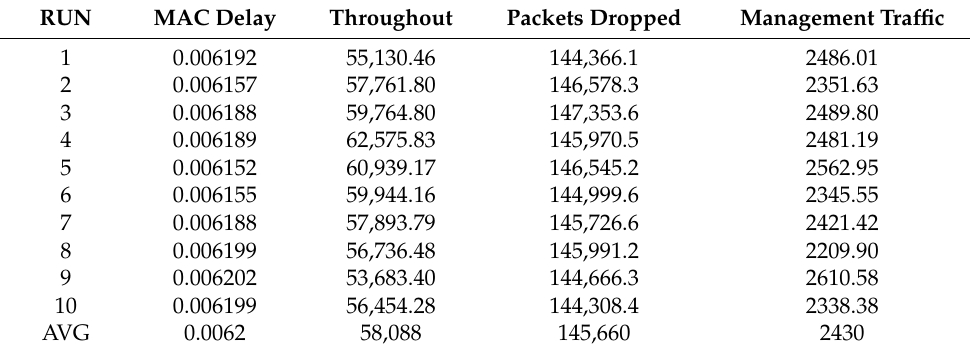
Table 10. Randomized Scenario